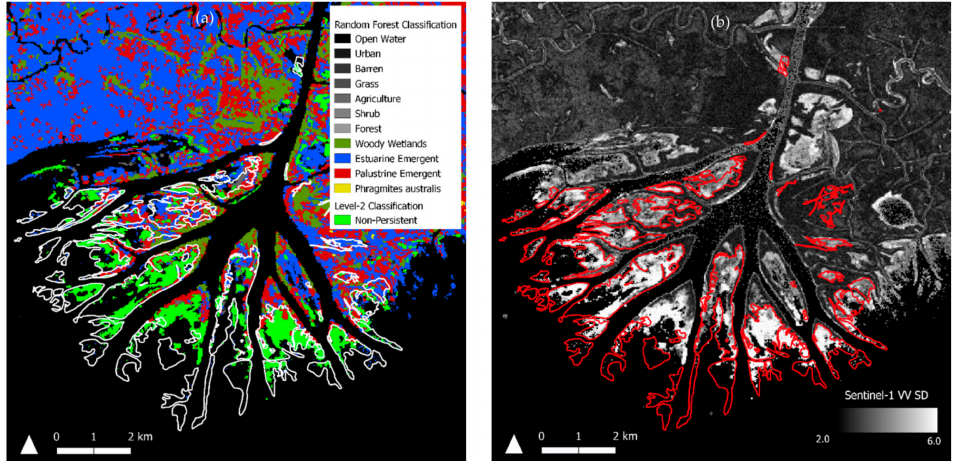
Figure 17. Left panel ( a ) depicts classified level-2 extents in 2017 NWI white polygons (white boundaries). Right panel ( b ) depicts the Sentinel-1 VV annual standard deviation layer with the same NWI polygons (red